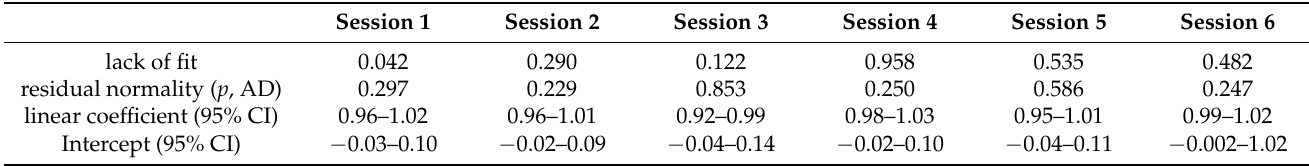
Table A3. Statistical results for regression analysis (HPAEC-PAD method, sample linearity) on data from each analysis